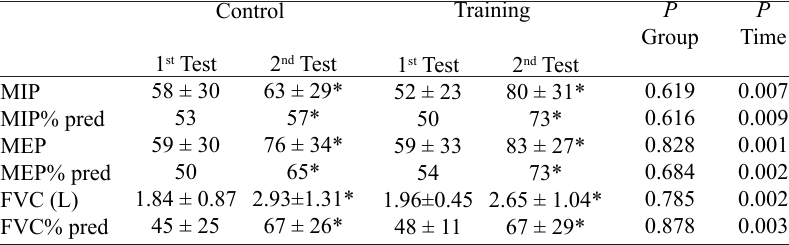
Table 2. Lung function variables before and after the implementation of training